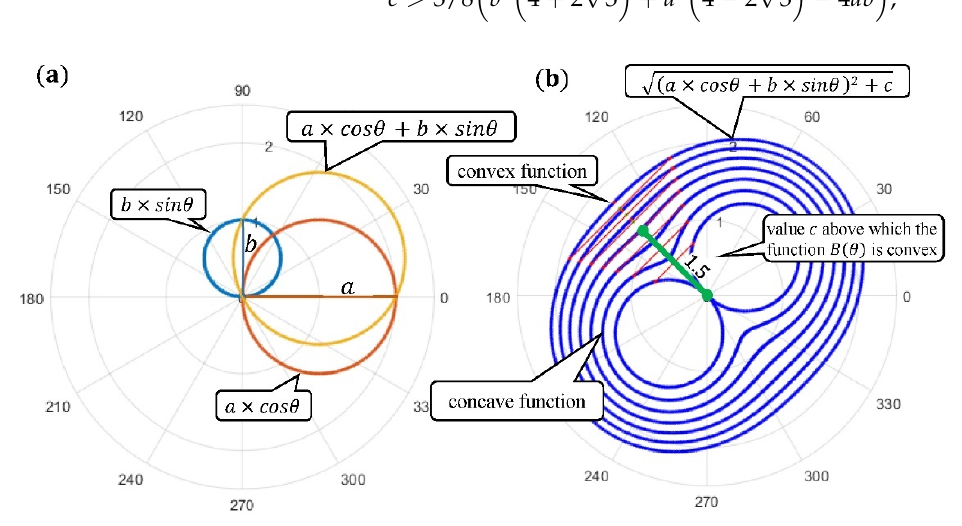
(cid:113) ( a × cos θ + b × sin θ ) 2 + c